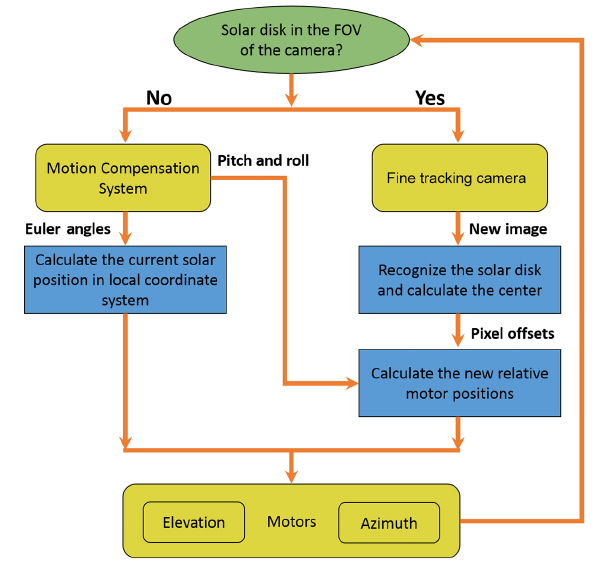
Figure 3. Flowchart of the tracking algorithm (see text for the de-